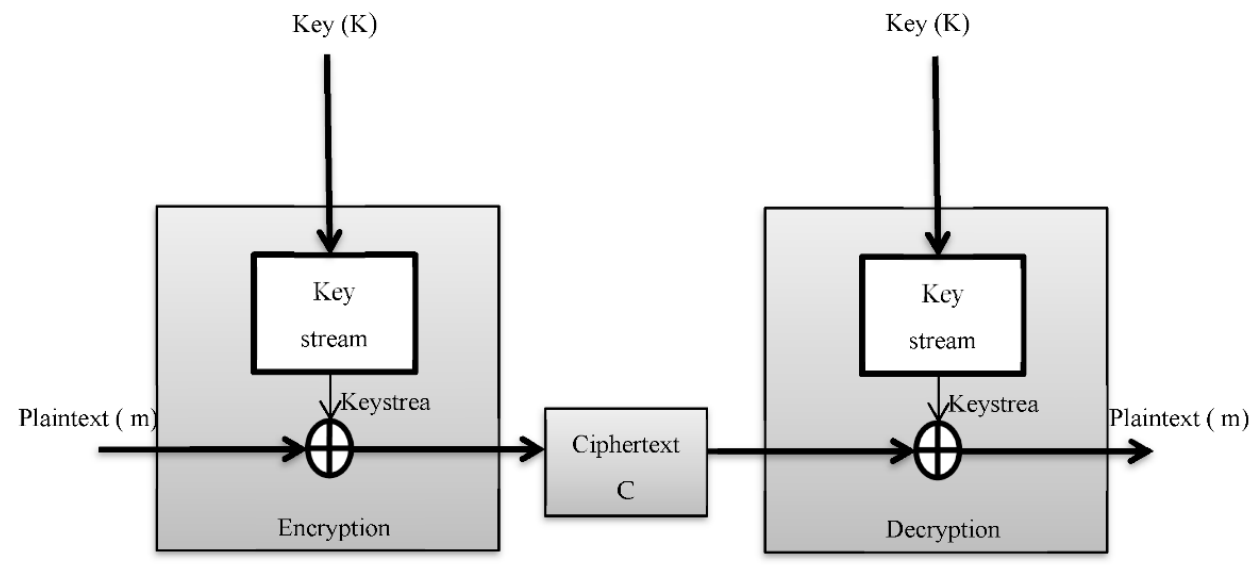
Figure 5. Stream cipher diagram.